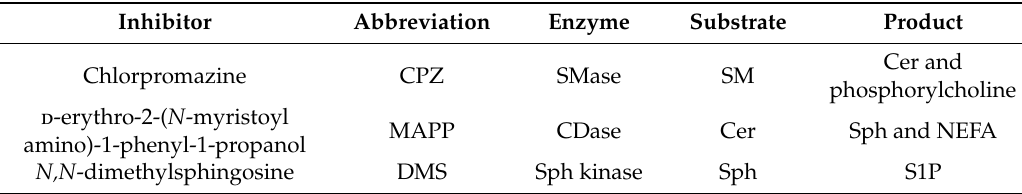
Table 1. Inhibitors used in the